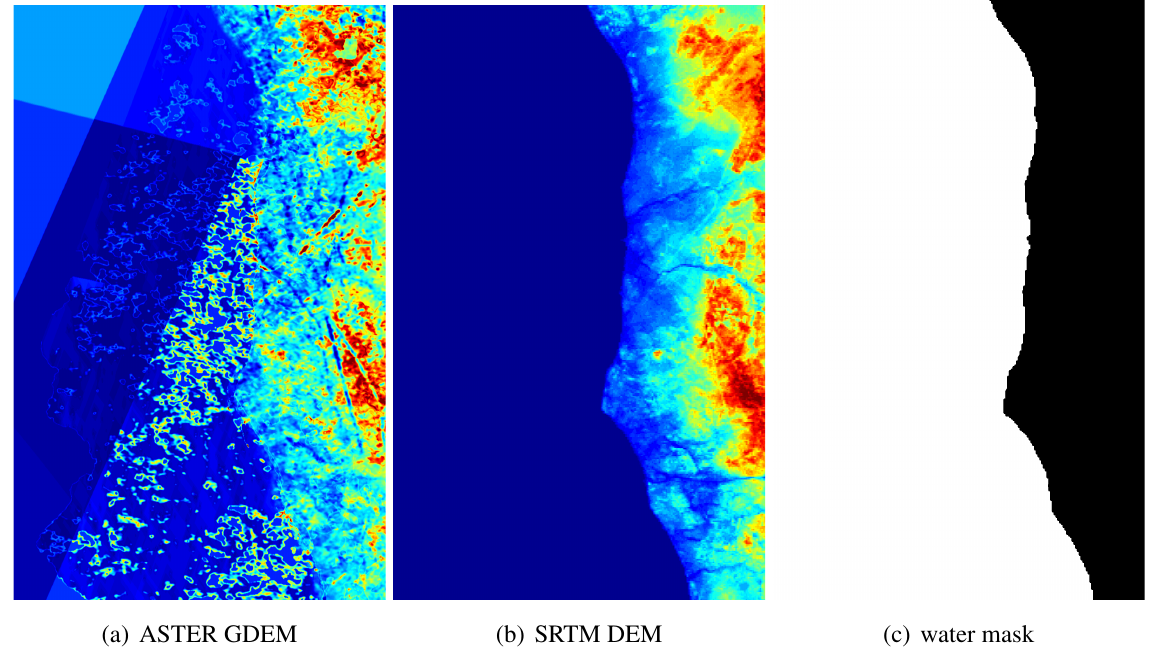
ASTER GDEM, SRTM, and water mask provided by GSHHS data (3 km × 1.4